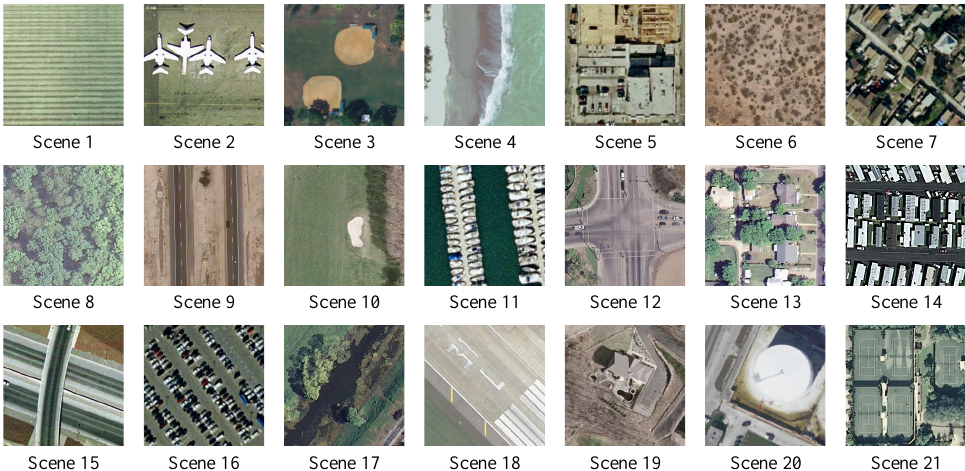
Figure 5. Examples of different scenes in UCM dataset. The names of scenes can be found in Table